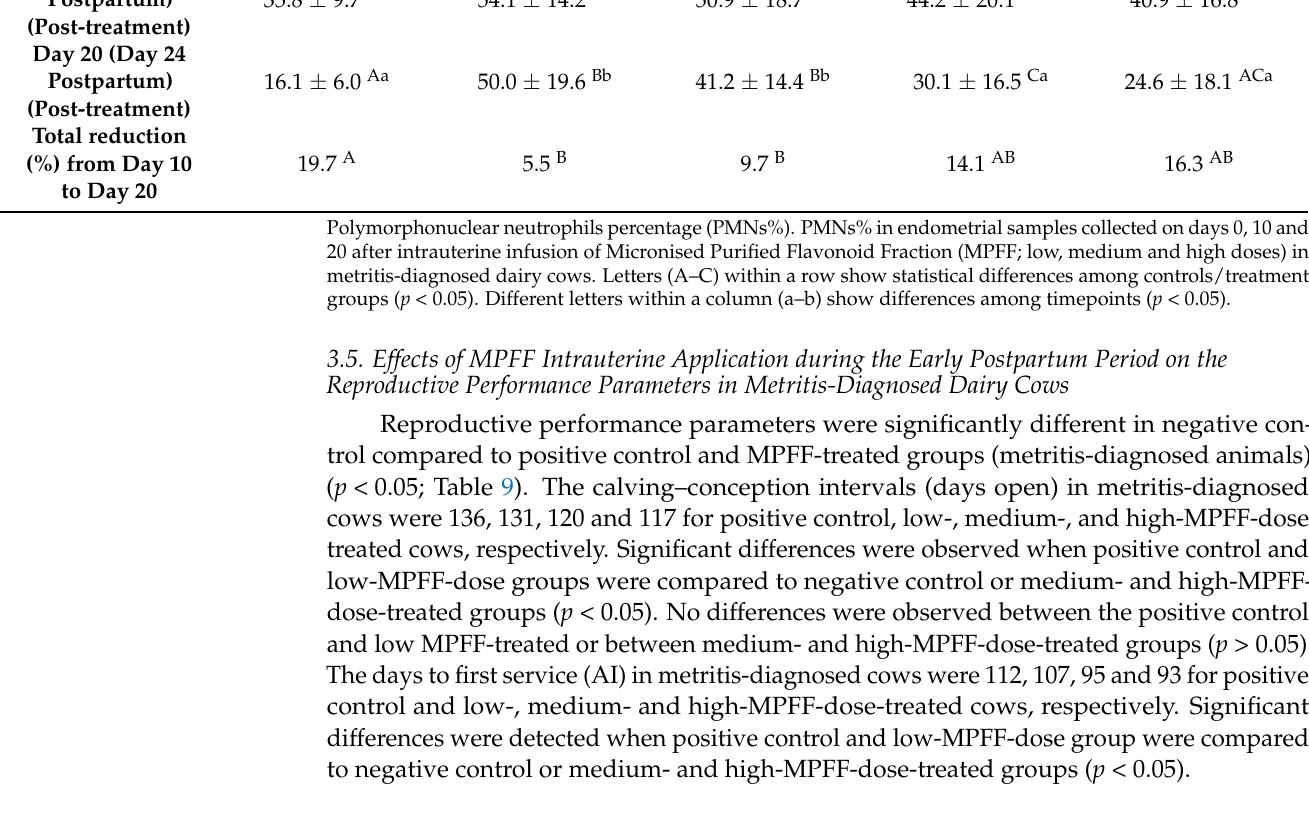
Table 9. Effects of intrauterine infusion of Micronised Purified Flavonoid Fraction (MPFF; low, medium and high concentrations) during the early postpartum period on the reproductive perfor- mance parameters in metritis-diagnosed dairy cows naturally infected by E. coli